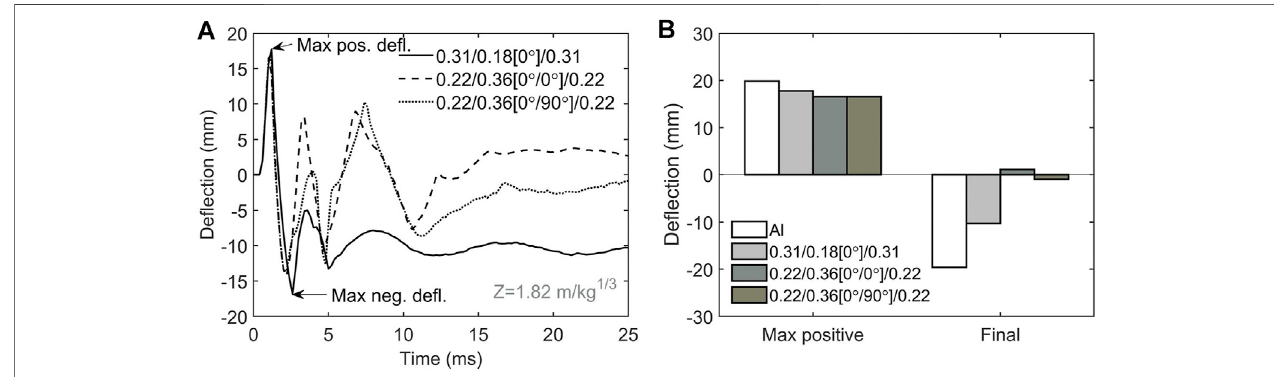
Frontiers in Materials |